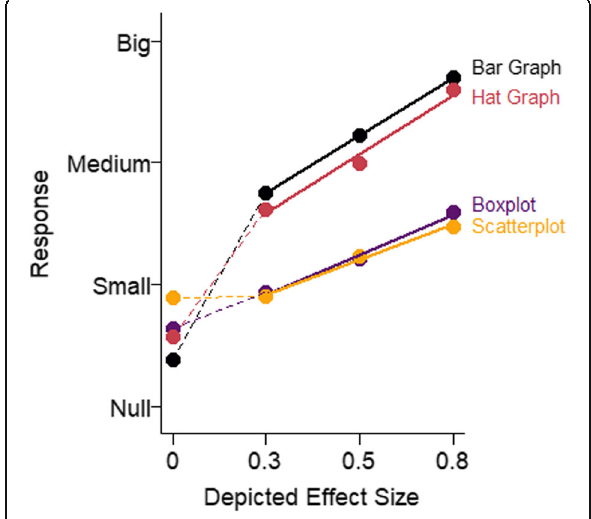
Fig. 16 Mean response is plotted as a function of depicted effect size in the stimuli and graph type for experiment 4. Solid lines represent the mixed linear model coefficients. Steeper lines indicate better sensitivity. The dashed lines connect the mean estimated magnitude of null effects and small effects. The data from the depicted null effects were not included in the